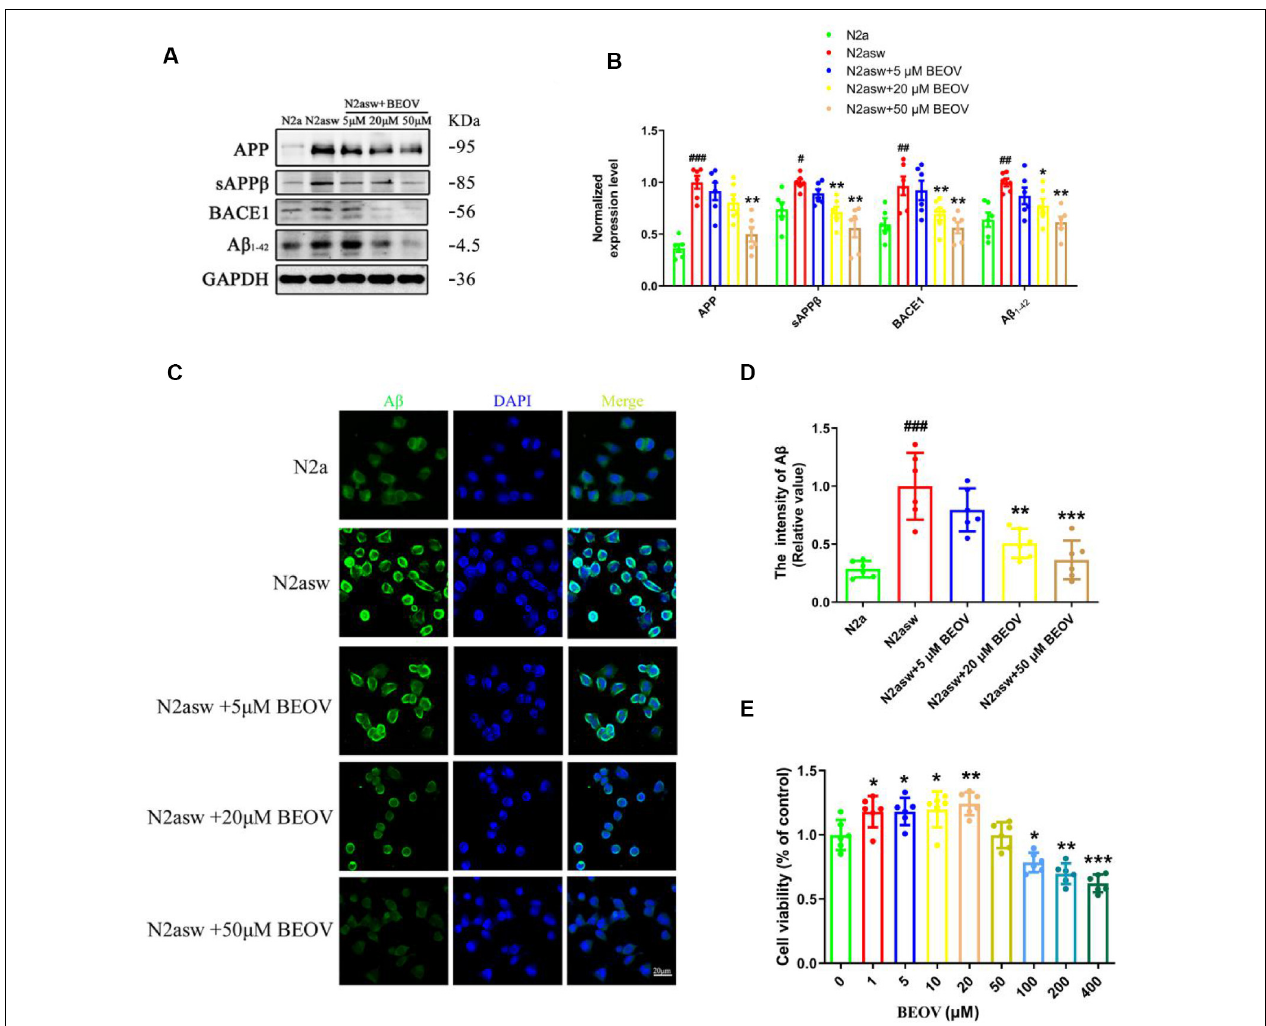
FIGURE 5 | Inhibition of BEOV on the amyloidogenic cascade in N2asw cells. (A,B) Western blot analysis and semi-quantification of several key proteins involved in the amyloidogenic cascade in N2a, N2asw, and BEOV-treated N2asw cells. Quantitative results were normalized against the levels of GAPDH. (C) Thioflavin S staining of A β in N2a, N2asw, and BEOV-treated N2asw cells. (D) The staining intensity of A β in those cells was quantified by software Image-Pro Plus Version 6.0. (E) CCK-8 assay of the viability of N2asw cells treated with BEOV at a series of dosages (1–400 µ M). Scale bar: 20 µ m. # N2a group vs. N2asw group; *N2asw + BEOV group vs. N2asw group. n = 6 wells per group, # P < 0.05, ## P < 0.01, ### P < 0.001, * P < 0.05, ** P < 0.01, and *** P < 0.001,